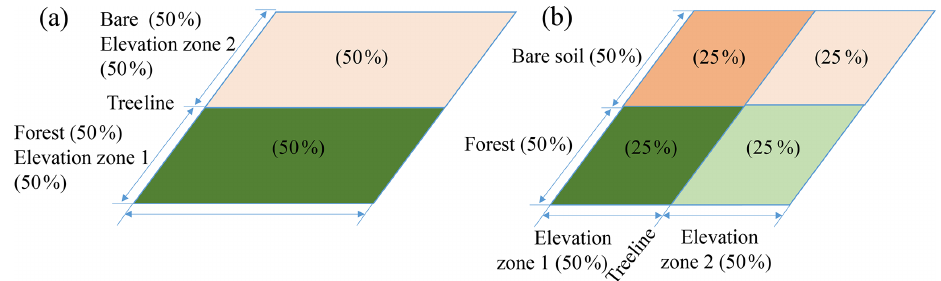
Figure 7. (a) The realistic configuration of a natural system with land cover consisting of 50% bare soil and 50% forest within a grid located in two different elevation zones above and below the treeline which is preserved with vector-based configurations and (b) the traditional VIC configurations for the given system at the grid for the two elevation zones and two land cover types which results in an unrealistic combination of forested land cover above the treeline and bare soil below the